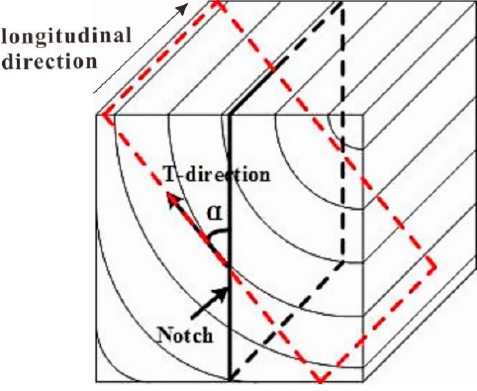
Figure 2. The angle α between the L – T plane (the red dotted areas) and the crack plane (the black dotted areas).